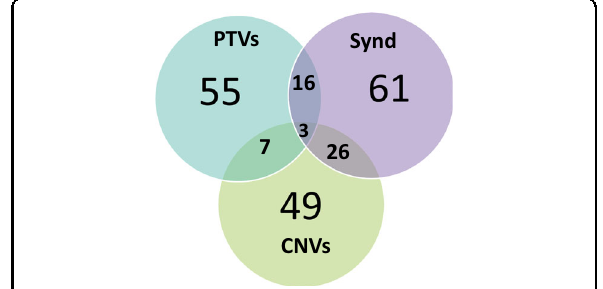
Fig. 1 Venn diagram of the gene list strati fi ed in three categories: syndromic genes, genes with an excess of de novo PTVs, genes intersected by a burden of rare CNVs.